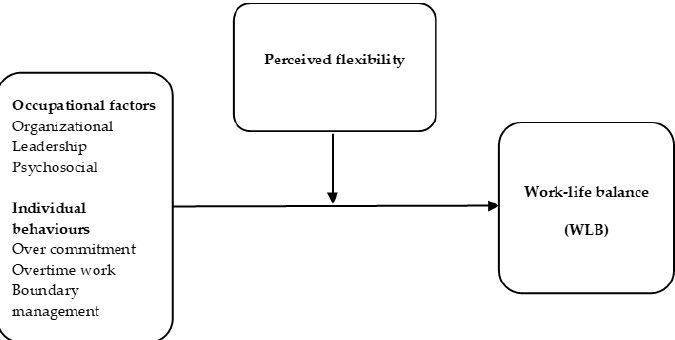
Figure 1. Model associating occupational factors and individual behaviours with work-life balance (WLB) (research question 1), with perceived flexibility as a modifier (research question 2).